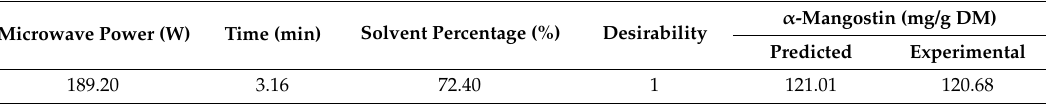
Table 3. The predicted and experimental values of α -mangostin obtained under the optimal extraction